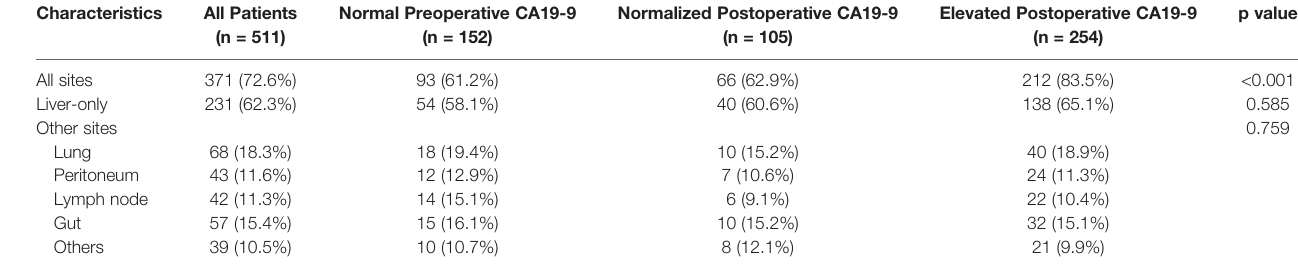
TABLE 3 | Analysis of sites of metastatic recurrence in relation to CA19-9 status.